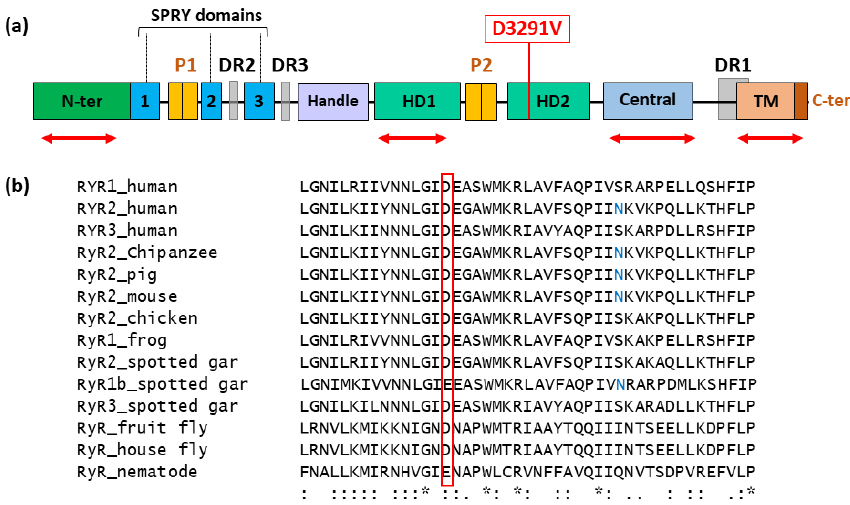
Figure 3. Location of the D3291V-RyR2 variant. ( a ) The D3291V variant is located in the HD2 outside the 4 mutation hotspots (red double arrows) where CPVT mutations are mostly found [39,40]. ( b ) Sequence alignment of RyR orthologues and paralogues. The Uniprot accession numbers are the following: Homo sapiens (RyR1 P21817, RyR2 Q92736, RyR3 Q15413), Pan troglodytes (RyR2 A0A2I3RIJ4) , Sus scrofa (RyR2 F1RHM3), Mus musculus (RyR2 E9Q401), Gallus gallus (RyR2